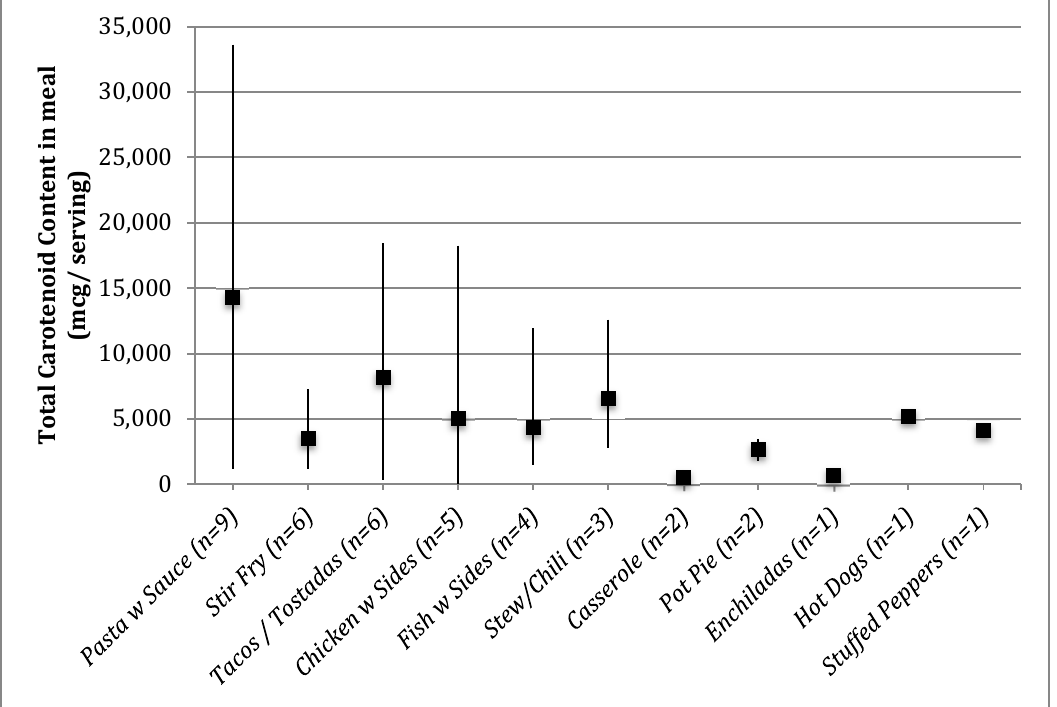
Table 3. Associations between combined carotenoids and fruit and vegetables (Pearson correlation). Total F / V Vegetables a Fruits Total Carotenoids